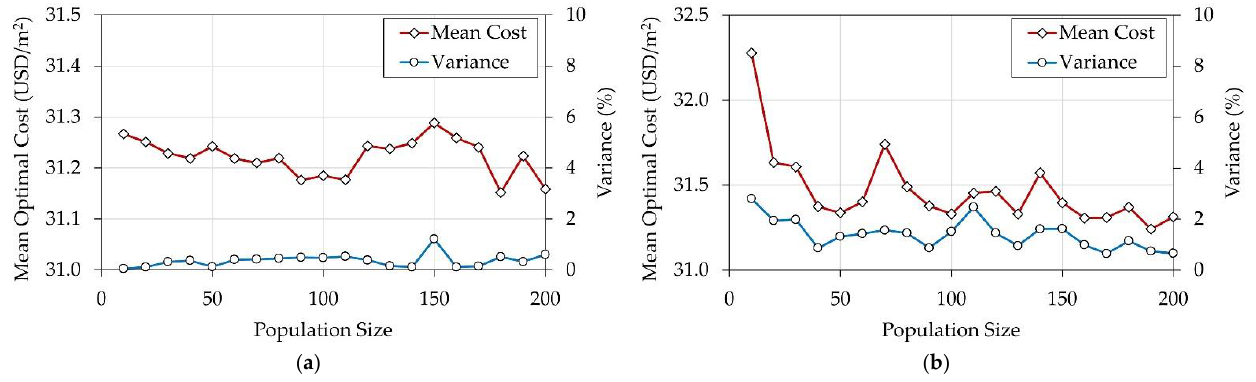
Figure 9. Effects of population size on mean optimal cost: ( a ) FSWD; ( b ) FP. Nine values were involved in tuning the crossover parameter (0.1–0.9) with a step-up value of 0.1. The default values for population size (200) and mutation rate (0.1) were kept constant during each run. Figure 10 illustrates the effects of the mutation rate on the mean optimal cost for each set of runs. For both systems, the difference between the mean costs was insignificant. Similar to the tuning of the population size, the variance was relatively small. Therefore, the default crossover rate value (0.5) could be maintained to achieve acceptable optimal results.